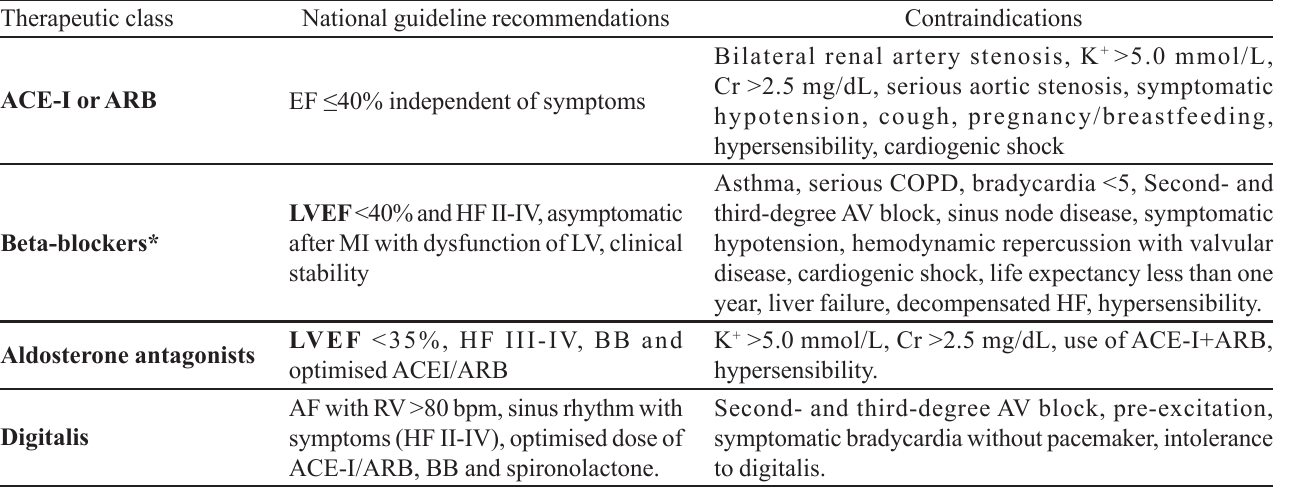
TABLE I - The general eligibility criteria for HF treatment according to therapeutic class and based on the national guidelines Therapeutic class National guideline